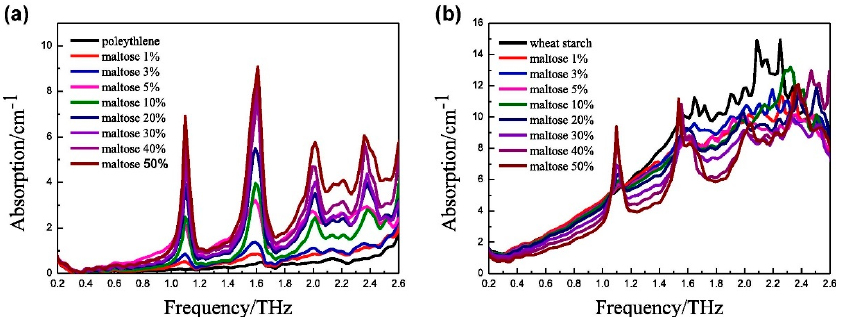
Figure 2. THz absorption spectra of maltose mixtures: ( a ) the maltose and polyethylene mixtures; ( b ) the maltose and wheat starch mixtures [66].